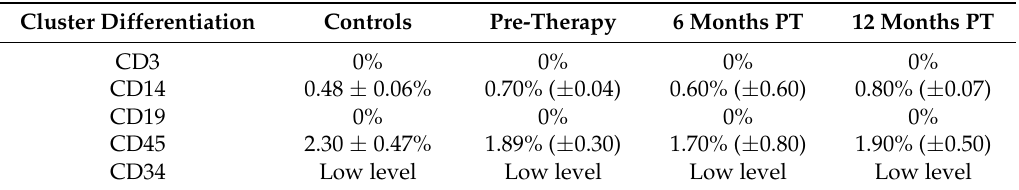
Table 2. Cell phenotype of MSC-like after depletion.